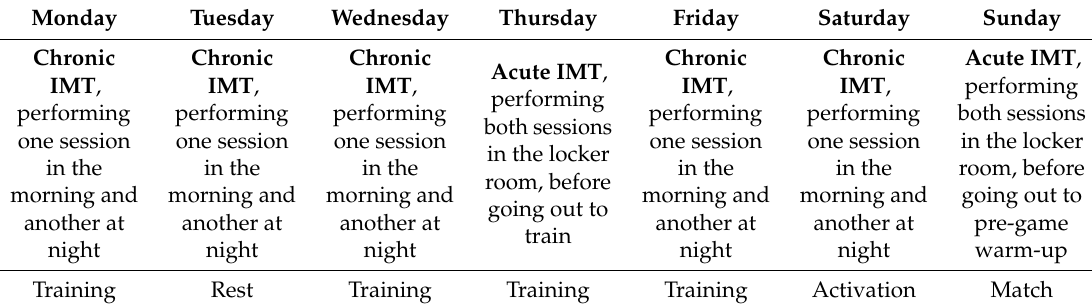
Table 5. Example microcycle using